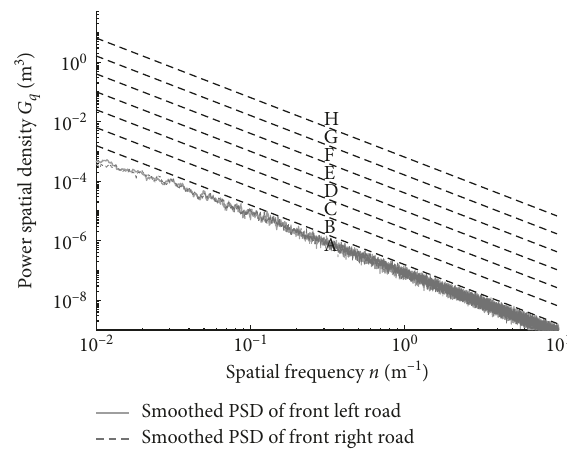
Figure 3: Road roughness classification and smoothed PSD of front left and right road generated.